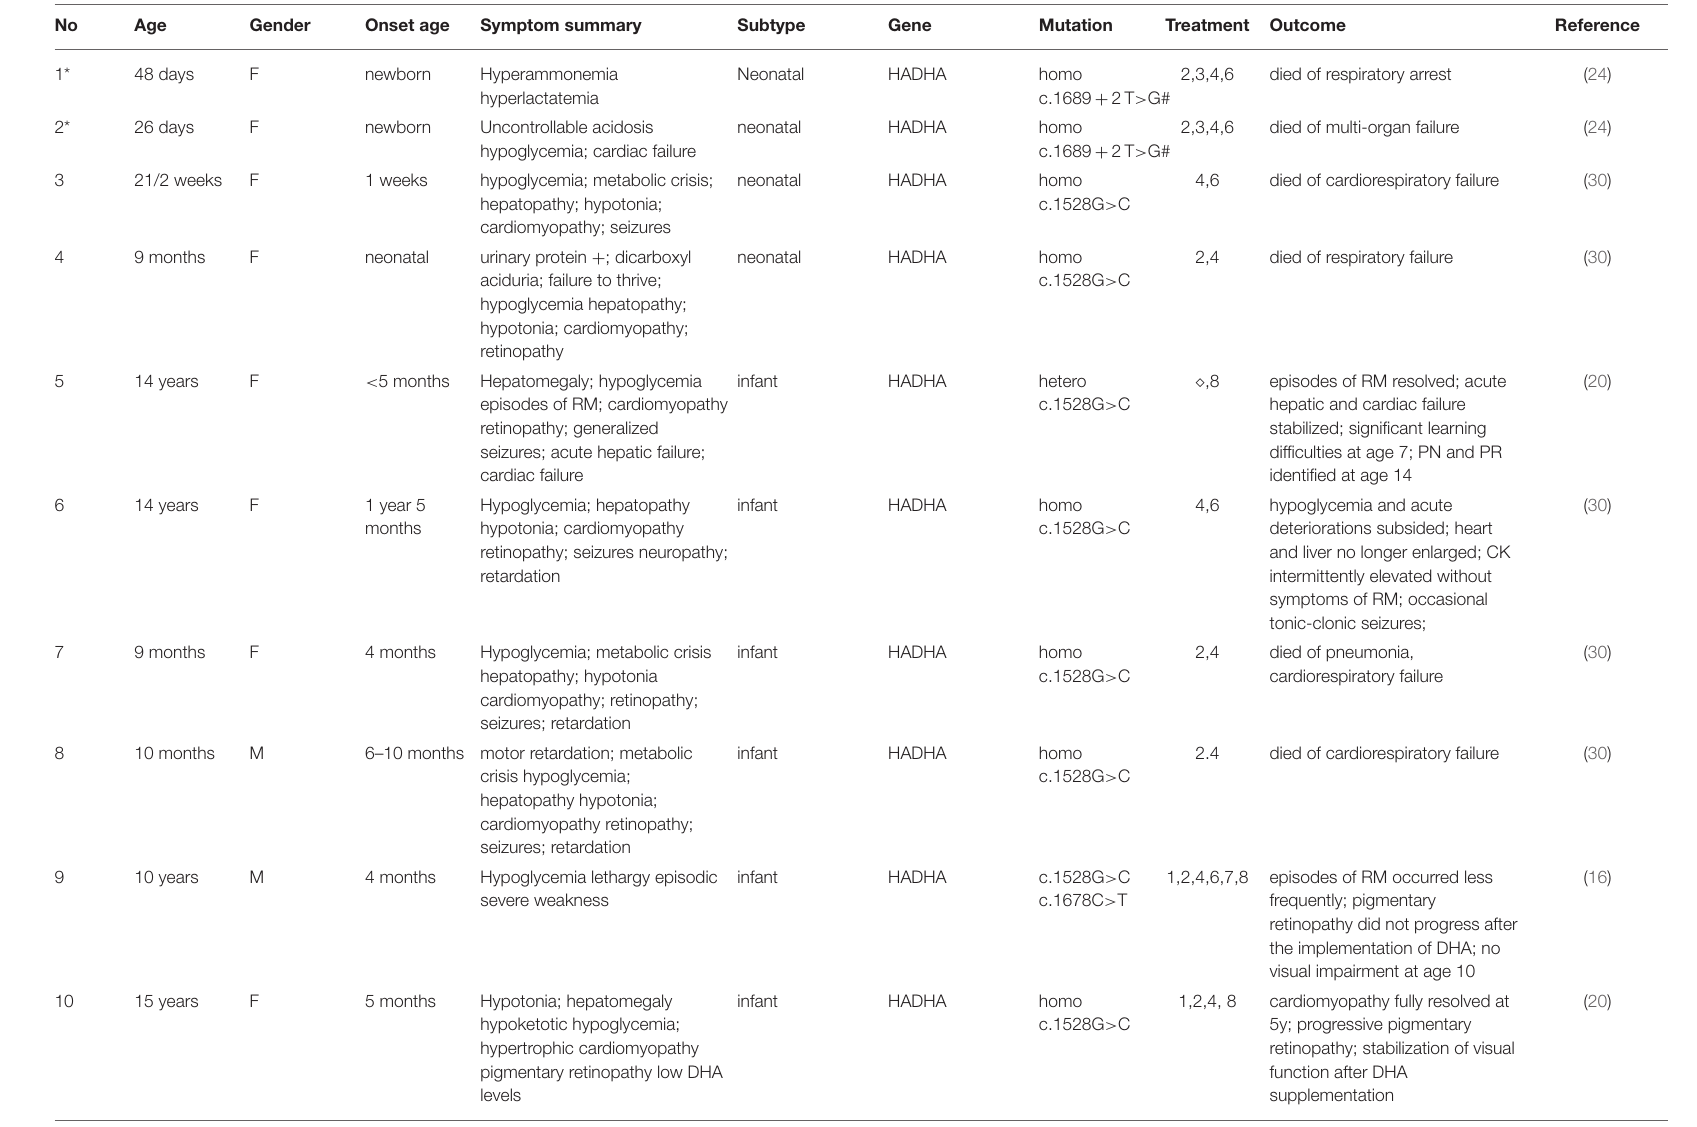
TABLE 2 | Dietary treatment of MTPD